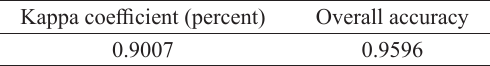
Kappa coefficient and overall accuracy of Landsat 8, image of 2013.